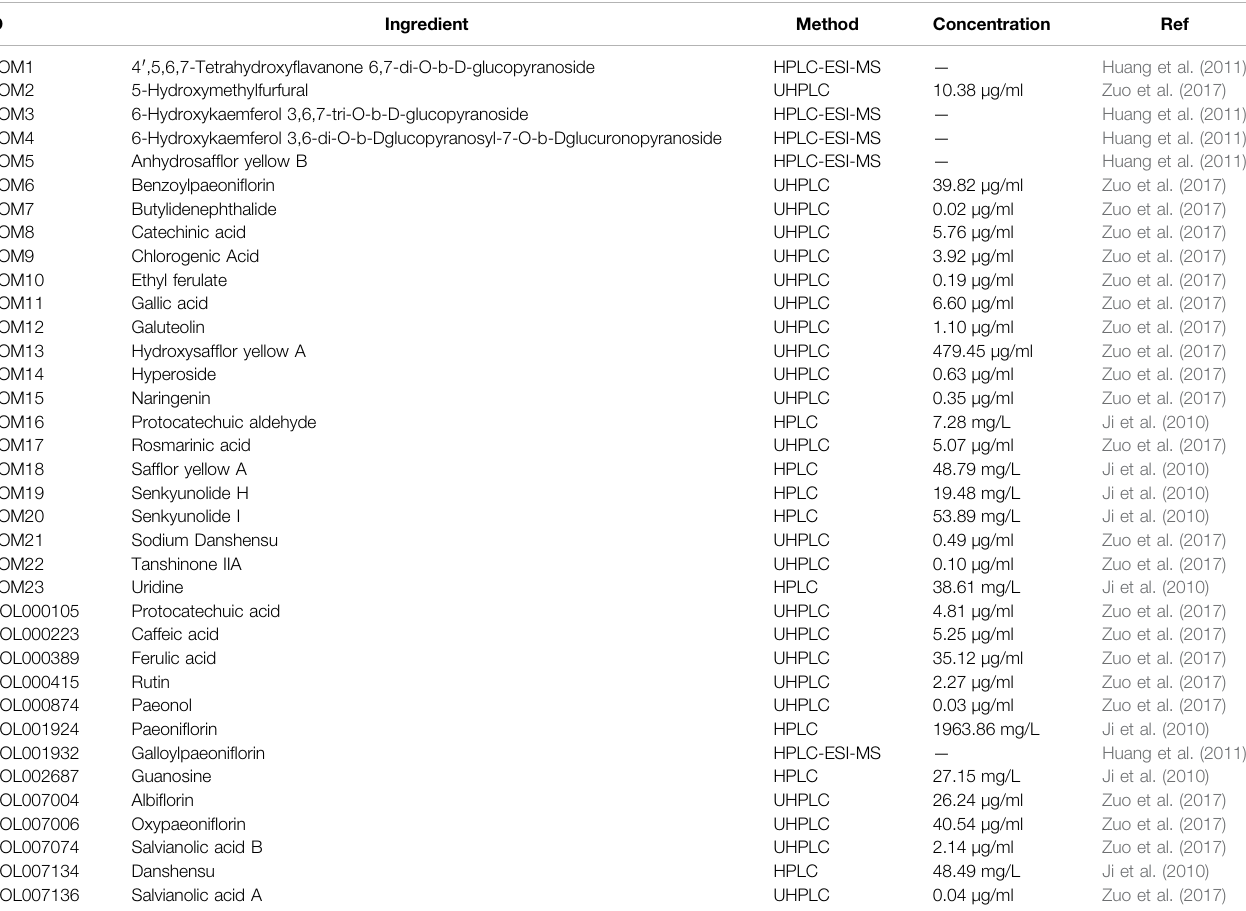
TABLE 1 | The information on the chemical analysis of the ingredients from the literature in fi ve botanical